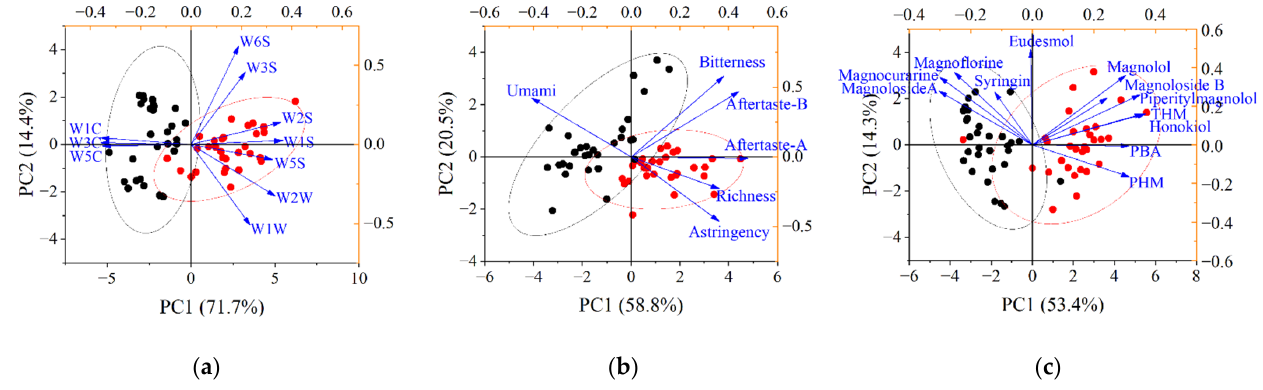
Figure 2. PCA analysis biplot: loading plot of the first two principal components with dataset from the e-nose ( a ), e-tongue ( b ), and chemical analysis ( c ); sample score plot where AYHP and JYHP samples are marked in black and red, respectively.